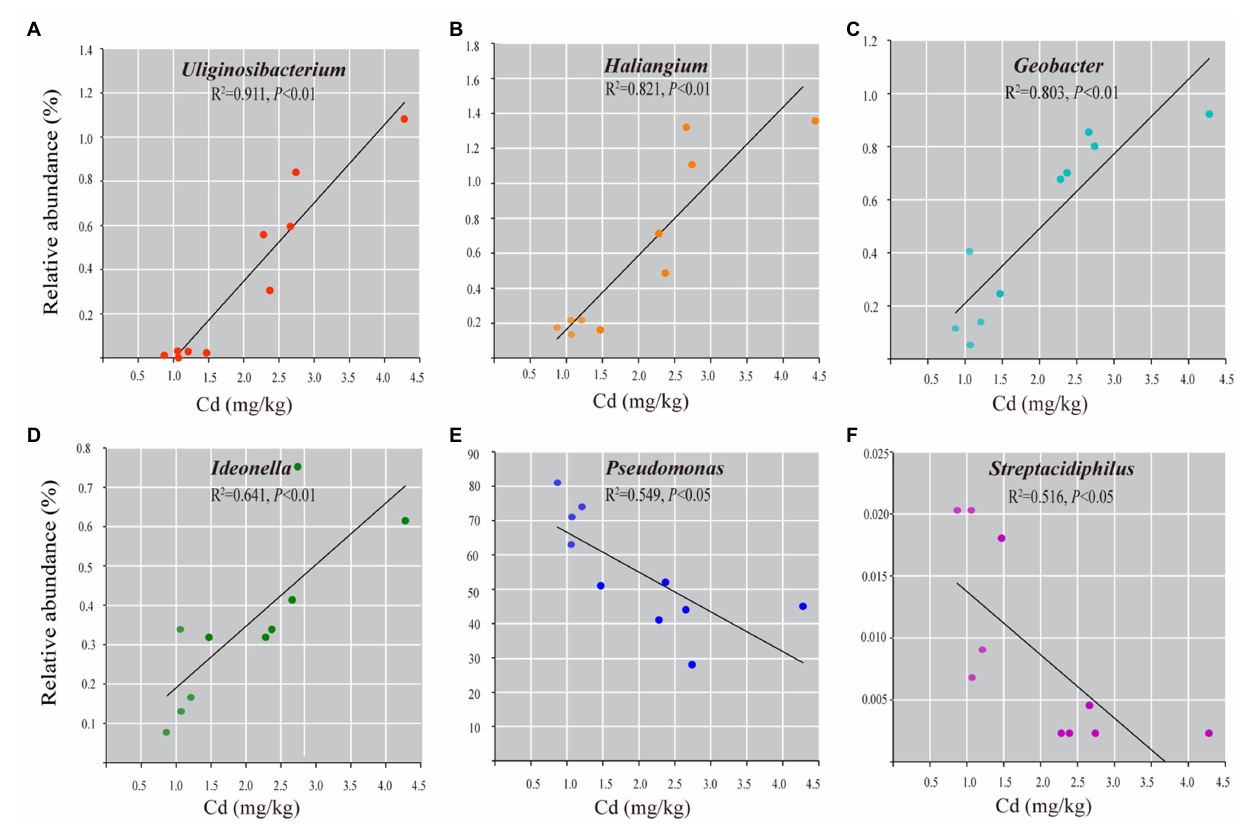
FIGURE 5 | The correlation analysis of the representative bacterial genera with Cd content in roots of rice grown in Cd-contaminated soil. Linear regression analyses show the relationships between the relative abundance of the genera of Geobacter (A) , Uliginosibacterium (B) , Haliangium (C) , Ideonella (D) , Pseudomonas (E) , and Streptacidiphilus (F) and Cd content (mg/kg dry weight). Only statistically significant correlations at p < 0.01 are